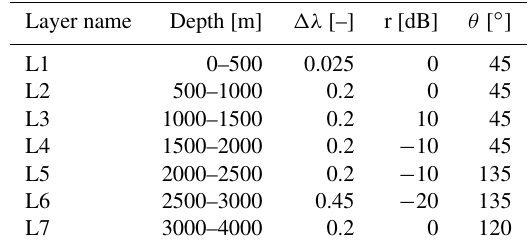
Table 2. The model parameters used to generate Fig. 3. In Eq. (5), components of T are calculated from (cid:49)λ assuming ε (cid:48) x = 3 . 15, and components of (cid:48) are calculated from r assuming (cid:48) x = 10 − 12 . The vertical gridding of the model is